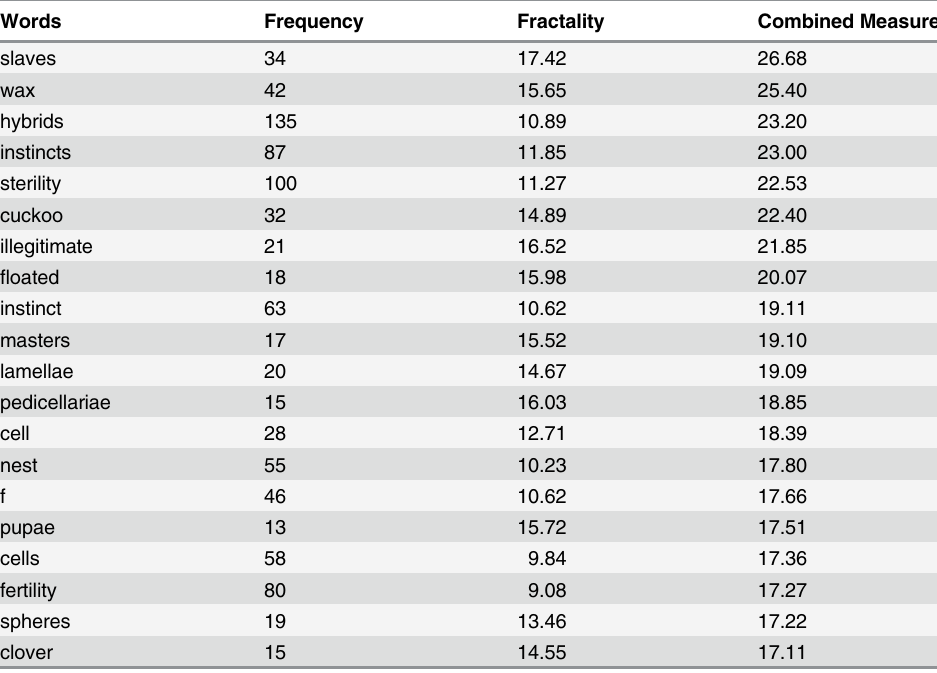
Table 2. List of the twenty top-ranked words according to Combined Measure from the book The Ori- gin of Species . These words are important according to the subject of the book. The word, f is related to some classification of species such as f8, f10, f14, ... and some proper names. f is kept because non-alpha- betical characters are removed in our method.